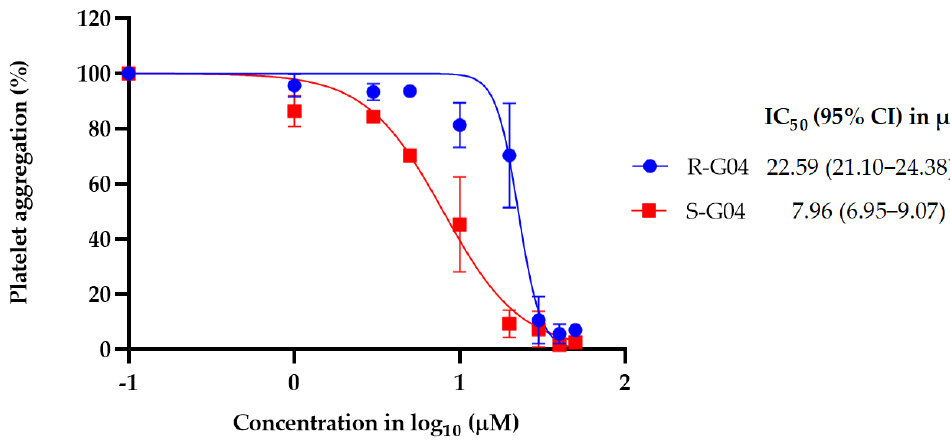
Figure 4. The IC 50 and 95% CI values for enantiomers R-G04 and S-G04 were calculated using the dose–response curves for washed human platelets using collagen (1 µg/mL) as an inducer of platelet aggregation. Data are representative of three independent experiments.